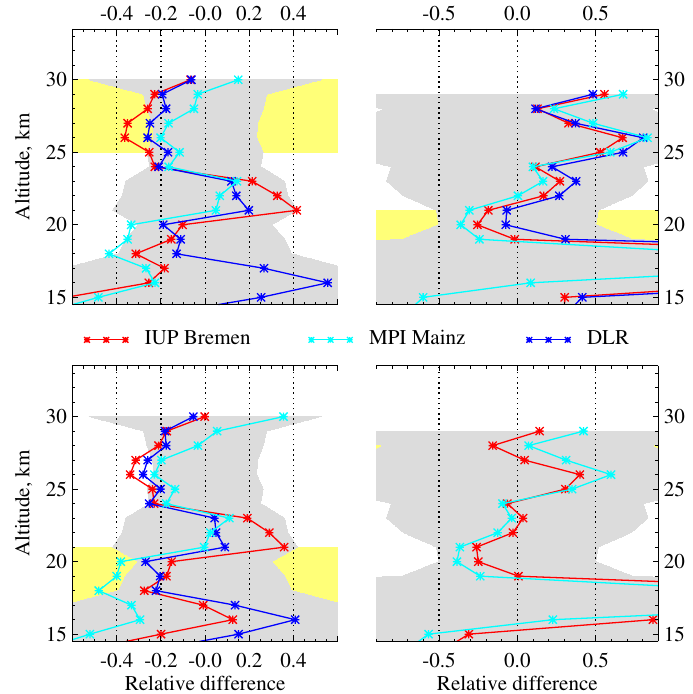
Fig. 28. Same as in Fig. 27 but for relative differences with respect to balloon-borne SAOZ results, e.g., IUP Bremen/SAOZ-1,